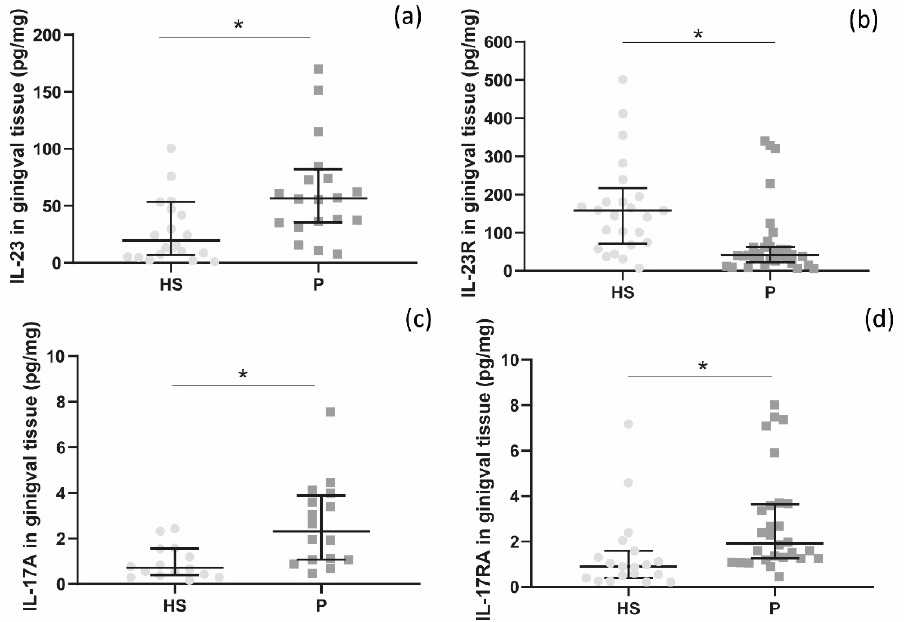
Figure 2. Levels of IL-23, IL-17A, IL-23R, and IL-17RA in gingival tissue. gingival tissue levels of IL-23 ( a ), IL-23R ( b ), IL-17A ( c ), and IL-17RA ( d ) from healthy subjects (HS) and periodontitis patients (P) which were detected by ELISA and are expressed as pg for each mg of gingival tissue. The results are shown as median and interquartile ranges. * A p -value ≤ 0.05 was considered significant.